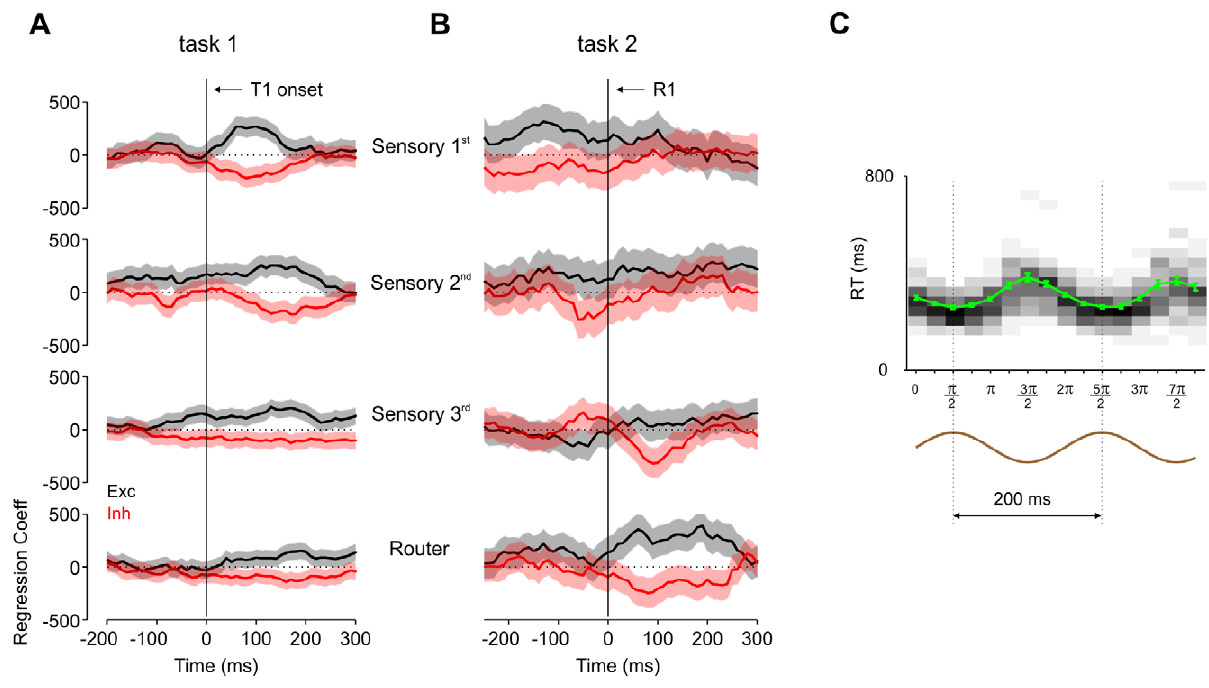
Figure 6. Response time sensitivity to stochastic fluctuations and low-frequency oscillations. (A,B) Coefficients of the linear regression model used to relate fluctuations in background inputs to response time variability. Black traces correspond to stimulus-selective excitatory populations at different processing levels, as indicated in the figure’s legend. Red traces correspond to inhibitory neurons within the same area. Shades depict 95% confidence intervals. A positive coefficient means that higher activity due to noise leads to faster responses. (A) Estimates for Task- 1 sensory and router populations, with RT1 as the independent variable. The x-axis indicates the time relative to stimulus onset, and thus positive values correspond to noise fluctuations occurring after stimulus onset. (B) Estimates for Task-2 sensory and router populations, with RT2 as the independent variable. Here, neural activity across different trials was locked to response 1 before the regression analysis. (C) Mean response times (green trace) for single-task simulations as a function of the phase between stimulus onset and background noise. The x-axis depicts the phase of stimulus onset relative to the background fluctuation (brown trace, bottom), and the y-axis depicts the mean response time in milliseconds. Error bars indicate the standard error of the mean. 50 trials were simulated for each individual phase. Also shown in grey-scale are the response time histograms (bin size of 40 ms).